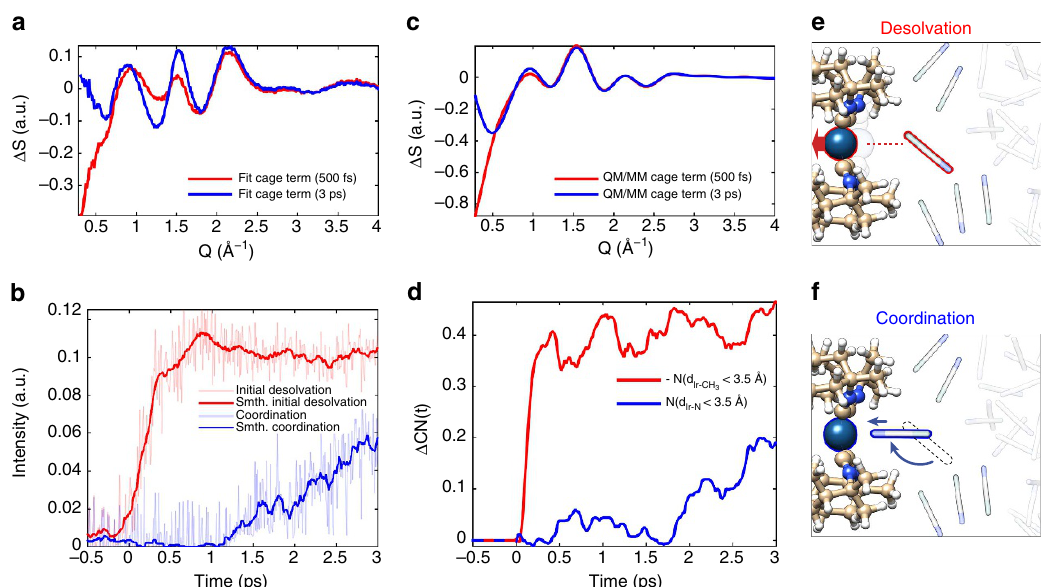
Figure 3 | Solvation dynamics of photoexcited [Ir 2 (dimen) 4 ] 2 þ in acetonitrile. ( a ) Solvation cage signal extracted from the difference scattering data recorded at time delays of 500fs and 3ps. ( b ) Evolution of the two experimentally determined solvation components. Full curves show the 15-point smoothed result, with the uncertainty being estimated by the point-to-point variation in the fit shown as transparent curves. ( c ) Simulated difference scattering from the solvent cage of the BOMD simulations for time delays of 500fs and 3ps. Simulated signal has been scaled by the 13% excitation fraction to facilitate comparison with cage term extracted from data. ( d ) Change in coordination number (CN) of the Ir atoms, by the methyl and nitrogen groups of the acetonitrile solvent after the excitation as predicted by the BOMD simulations (note that the methyl coordination change is negative). ( e , f ) Schematic depiction of the processes giving rise to the solvation signal measured in the difference scattering data; ( e ) An initial loss of solvation of the Ir atoms of [Ir 2 (dimen) 4 ] 2 þ by the methyl groups of the acetonitrile solvent and ( f ) a coordination of the Ir atoms of the excited state [Ir 2 (dimen) 4 ] 2 þ by the nitrogen groups of the acetonitrile